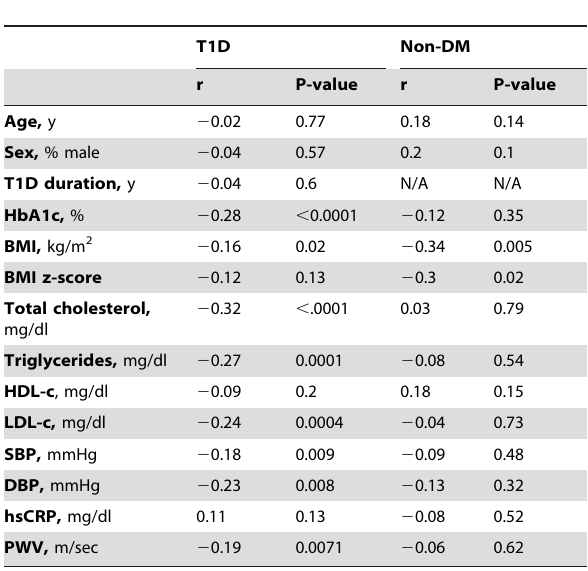
Table 2. Correlations of Vitamin D to potentially confounding